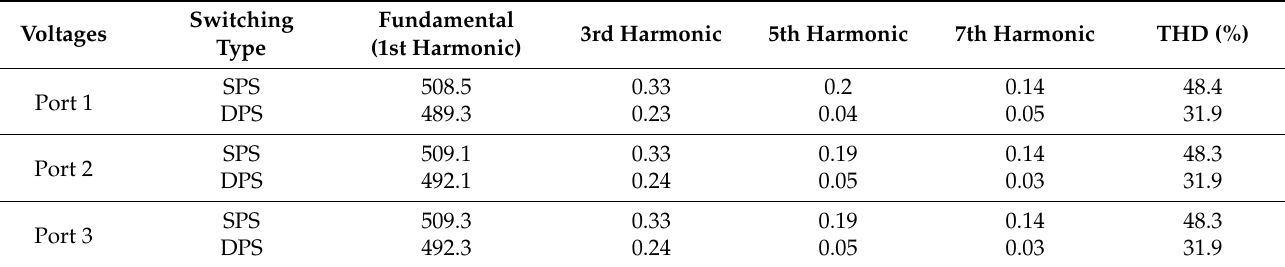
Table 2. Harmonic distortion for the transformer voltages.